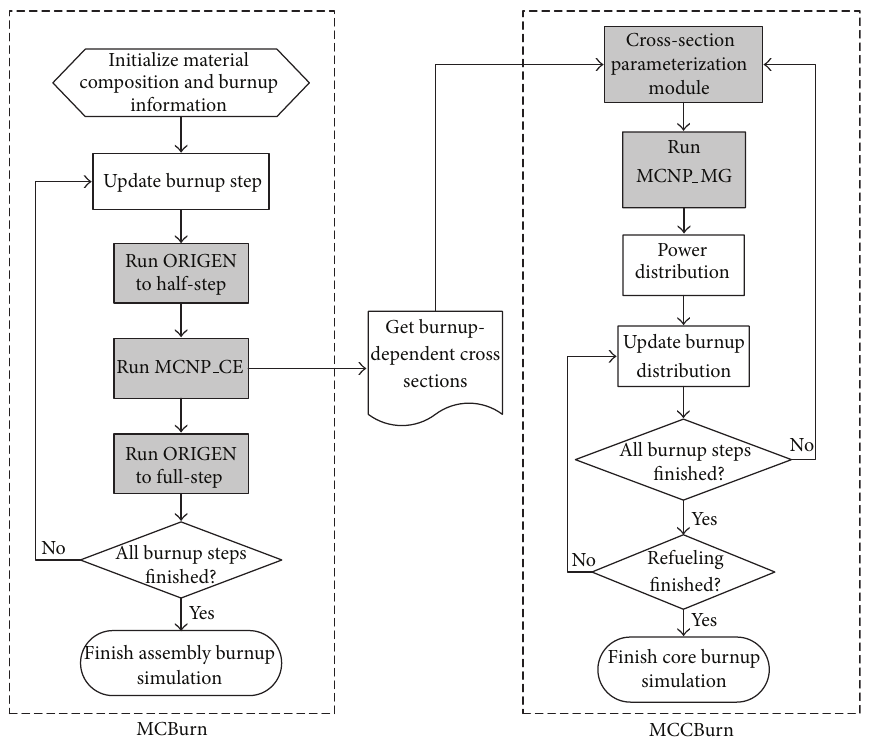
Figure 3: Two-step Monte Carlo core burnup analysis